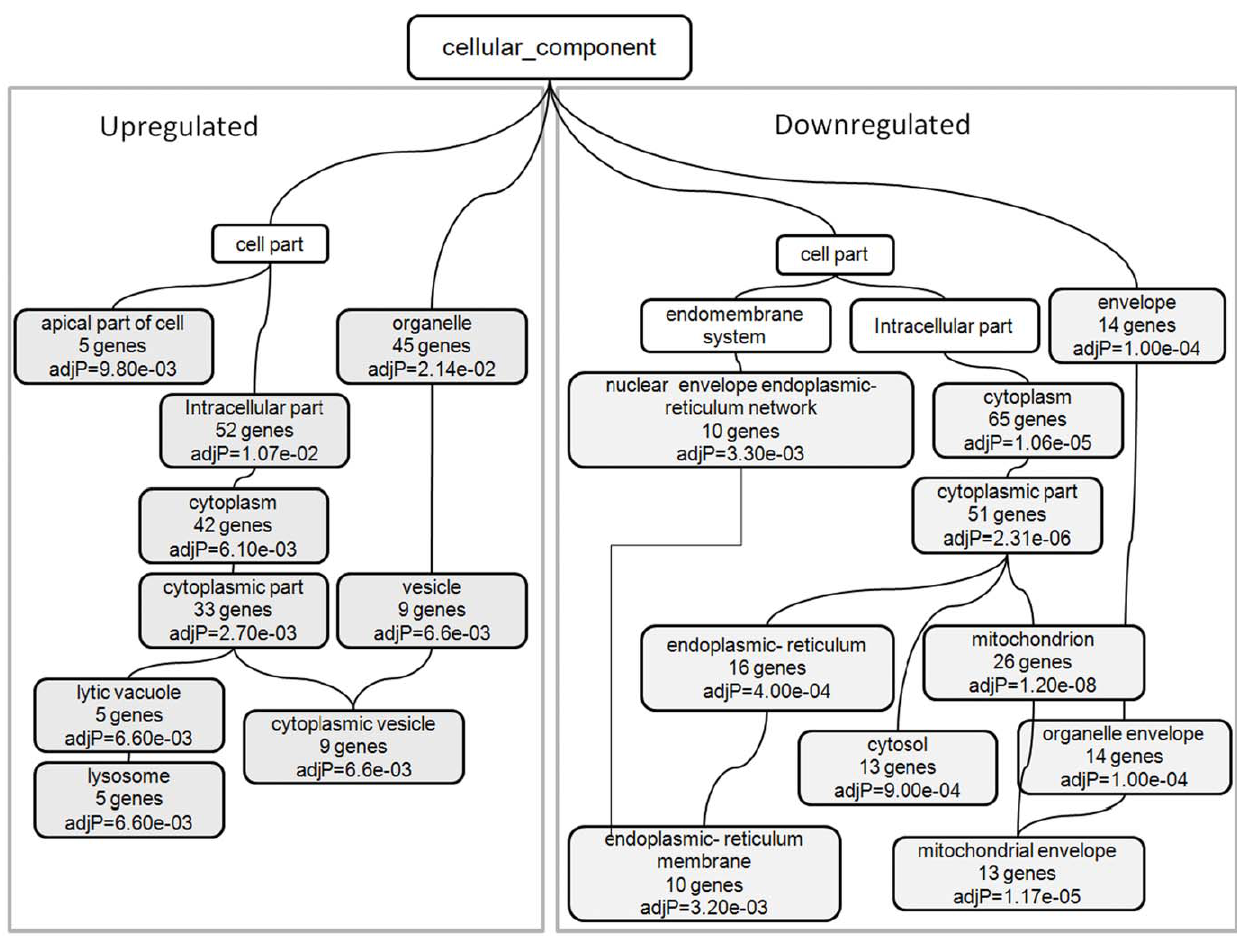
Figure 4. Gene Ontology tree representing the cellular compartments enriched by upregulated and downregulated set of genes. Gene ontology analysis was performed using the GOTree Machine software which performs the hypergeometric test to evaluate the significance of enrichment for each category by determining if the observed number of gene counts exceeded the expected counts. Among the cellular compartments mitochondrion and endoplasmic reticulum are enriched by downregulated genes and vacuole, vesicle, lysosome are significantly enriched by upregulated genes.